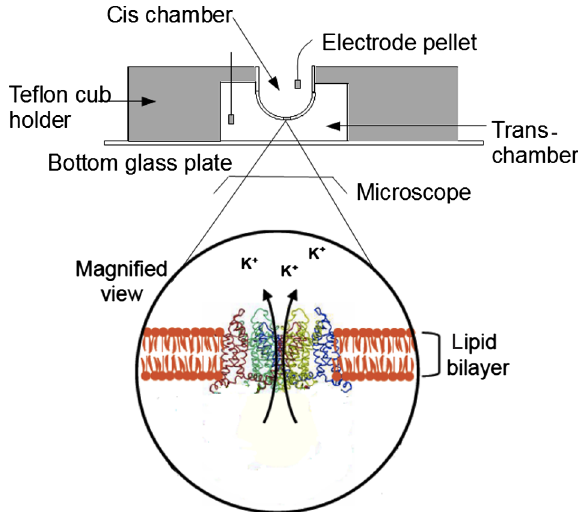
FIG. 4. The planar-lipid-bilayer system. The artificial bilayer is stretched acrossan approximately 100 - (cid:2) m hole crafted in a plastic test tube mounted on a Teflon holder. Electrical connections to the bilayer chamber are made via Ag = AgCl electrodes. The whole system is mounted onto the x - y stage of an inverted